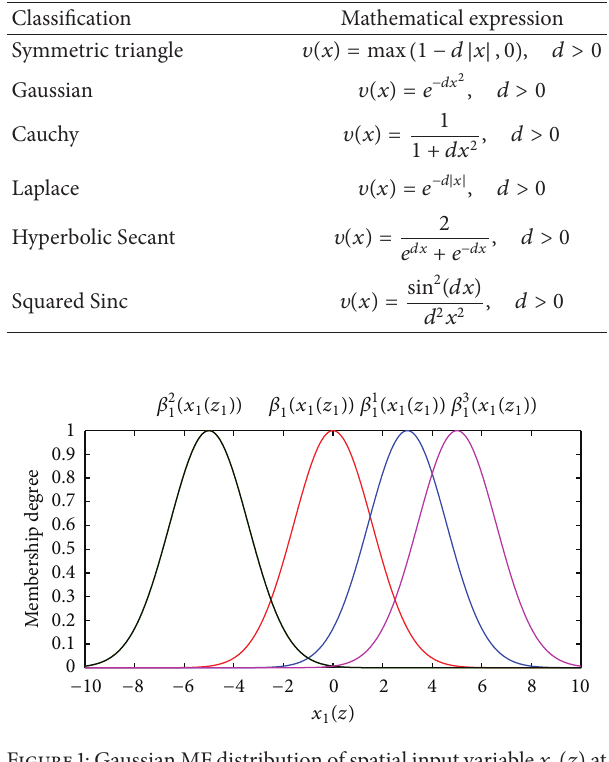
Figure 1: Gaussian MF distribution of spatial input variable 𝑥 1 (𝑧) at sensing location 𝑧 = 𝑧 1 . 𝛽 1 1 (𝑥 1 (𝑧 1 )) , 𝛽 2 1 (𝑥 1 (𝑧 1 )) , and 𝛽 3 1 (𝑥 1 (𝑧 1 )) are generated by the Gaussian type reference function 𝛽 1 (𝑥 1 (𝑧 1 ))